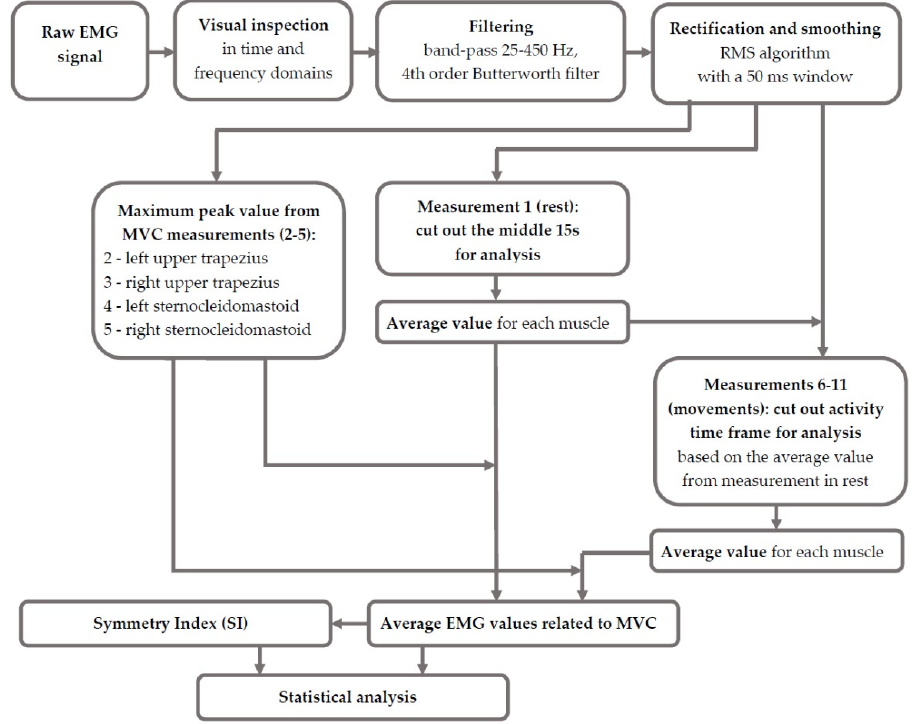
Figure 4. EMG data analysis